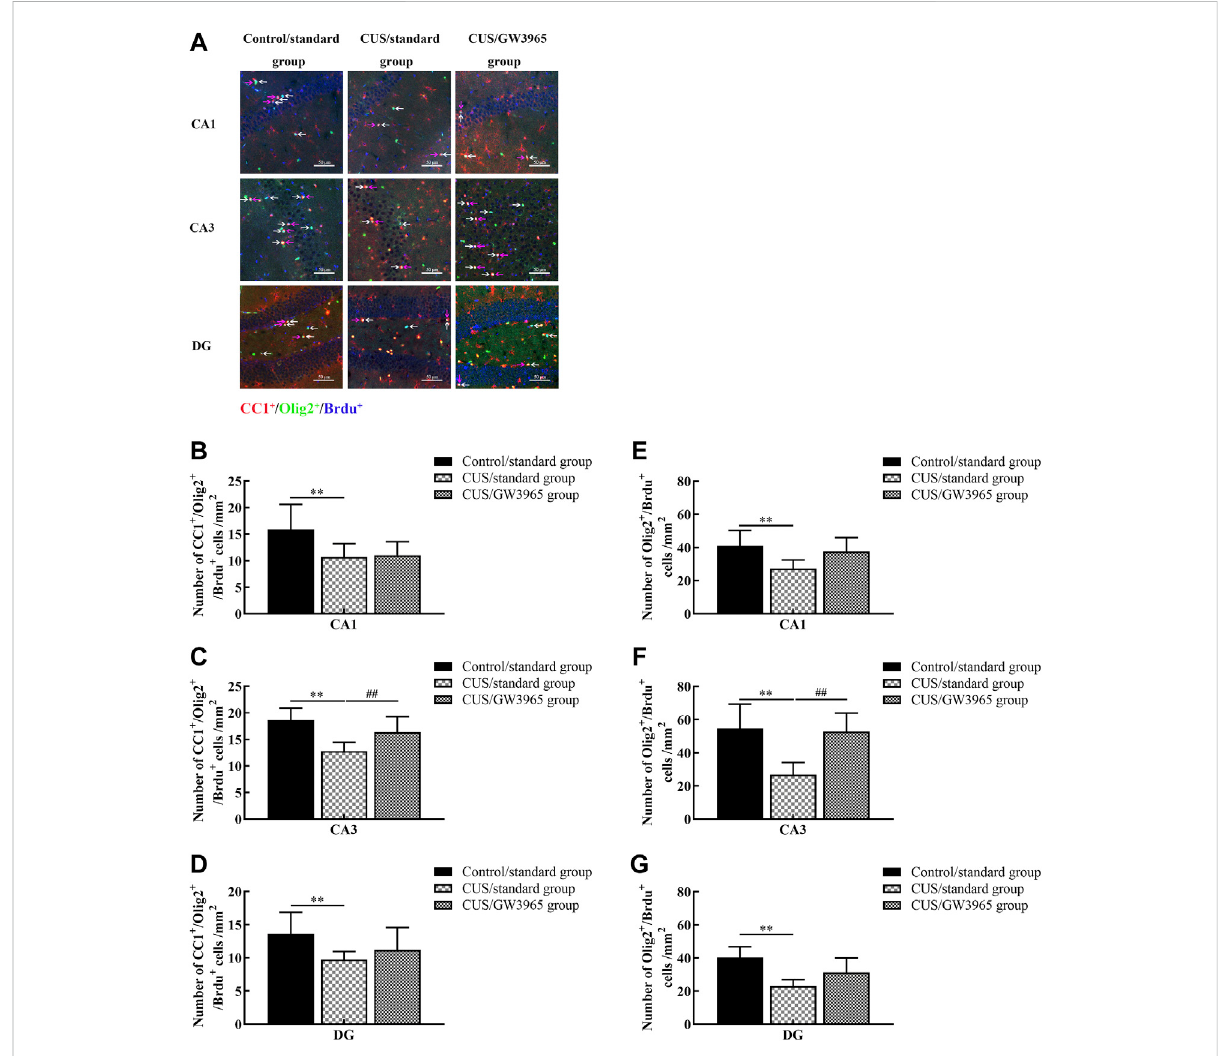
FIGURE 4 Illustration of the Olig2 + /BrdU + and CC1 + /Olig2 + /BrdU + cell densities. (A) Representative images of the immuno fl uorescence staining of Olig2 + /BrdU + cells and CC1 + /Olig2 + /BrdU + cells in the CA1, CA3 and DG areas of the hippocampus in the Control/standard group, the CUS/ standard group and the CUS/GW3965 group. CC1 + : red, Olig2 + : green, BrdU + : blue. The white arrows indicate Olig2 + /BrdU + cells. The red arrows indicate CC1 + /Olig2 + /BrdU + cells. Bar = 50 μ m. (B) Comparisons of the CC1 + /Olig2 + /BrdU + cell densities in CA1 region among the three groups. (C) Comparisons of the CC1 + /Olig2 + /BrdU + cell densities in CA3 region among the three groups. (D) Comparisons of the CC1 + /Olig2 + /BrdU + cell densities in DG region among the three groups. (E) Comparisons of the Olig2 + /BrdU + cell densities in CA1 region of the hippocampus among the three groups. (F) Comparisons of the Olig2 + /BrdU + cell densities in CA3 region among the three groups. (G) Comparisons of the Olig2 + /BrdU + cell densities in DG region among the three groups. pp indicates p < 0.05 for the CUS/standard group compared with the Control/standard group. ## indicates p < 0.05 for the CUS/standard group compared with the CUS/GW3965 group. All the data are shown as the means ±